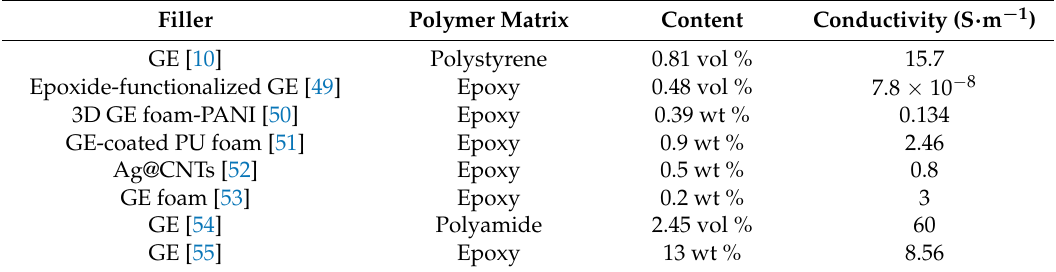
Table 3. The conductivity of the polymer composites filled with different fillers in previous